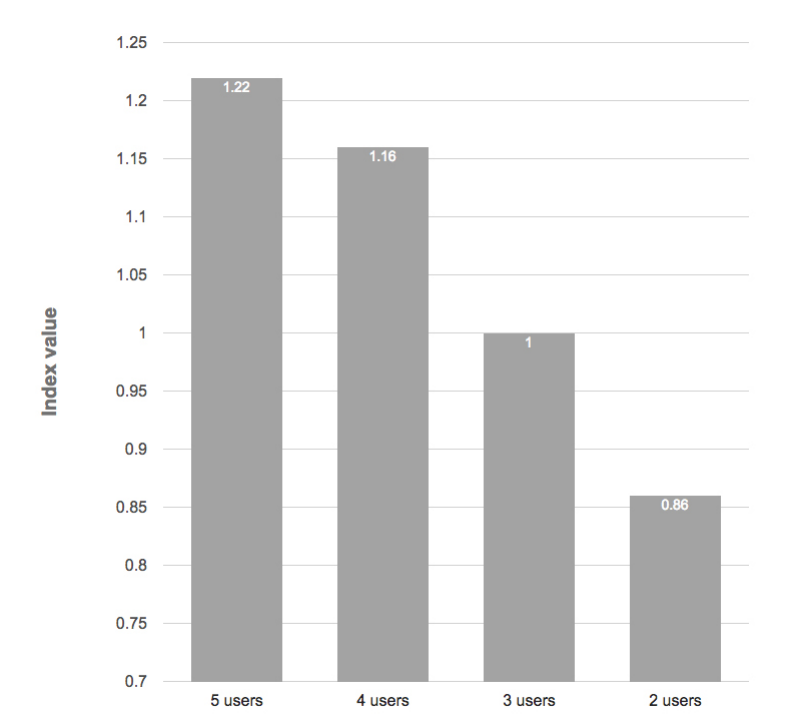
Figure 8. Index value for different numbers of